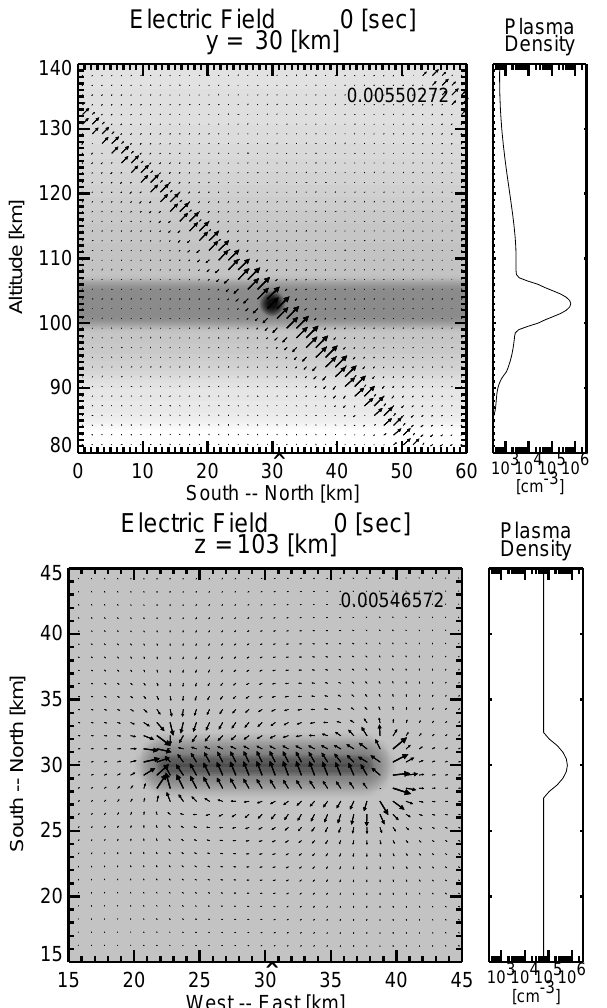
Fig. 4. Electric field generated with the condition obtained in the SEEK-2 campaign. The plasma cloud is assumed as to be a rod-like structure, as used in Yokoyama et al. (2004a). Background gray- scale contours represent plasma density in the sliced 2-D planes, and arrows represent the polarization electric fields.